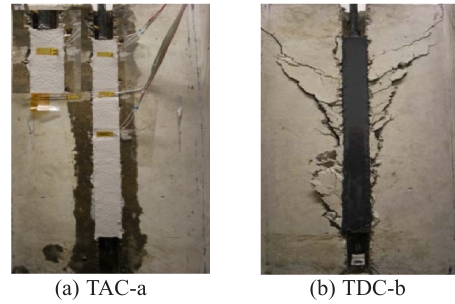
Fig. 3. Failure mode of specimens with CFRP